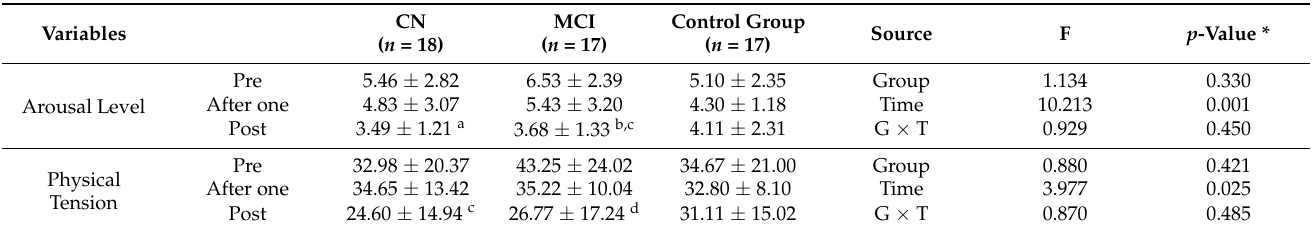
Table 2. Changes in electroencephalogram